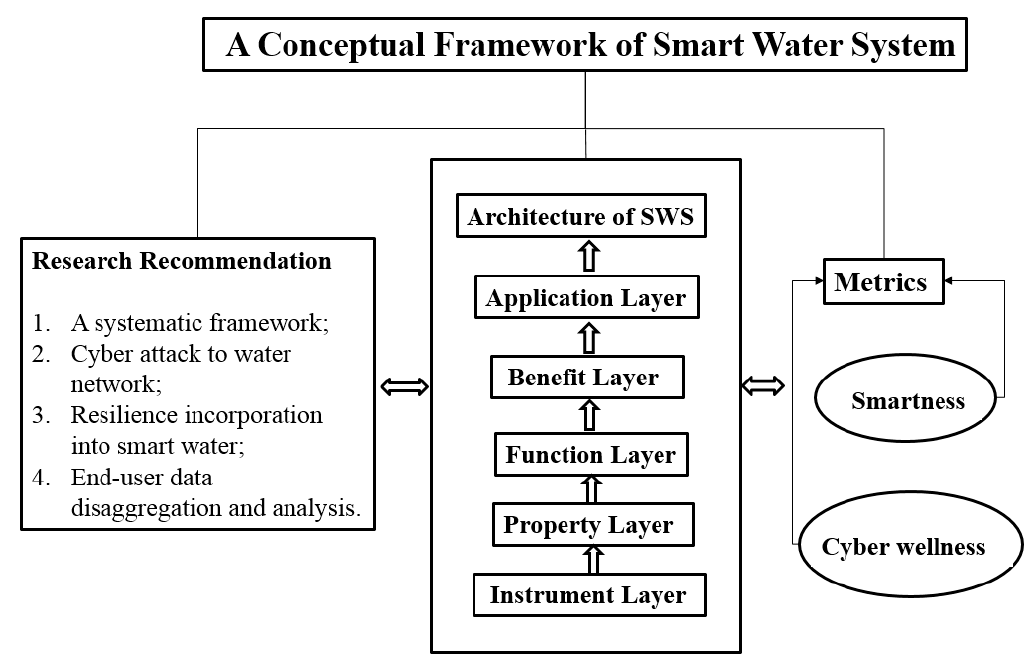
Figure 5. A New Framework of Smart Water System.